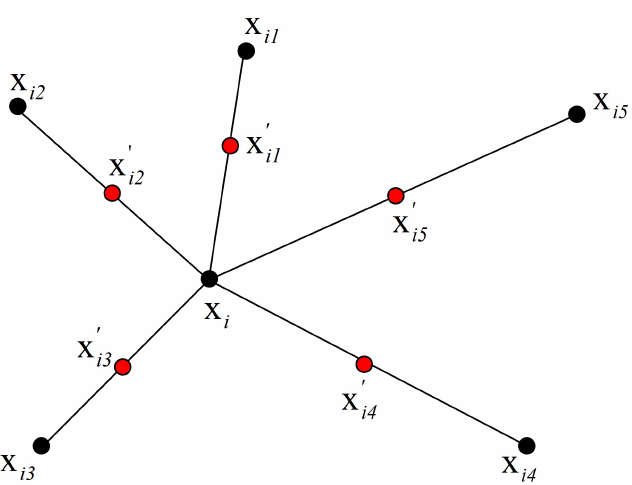
Figure 12. An illustration of how to create the synthetic data points in the SMOTE